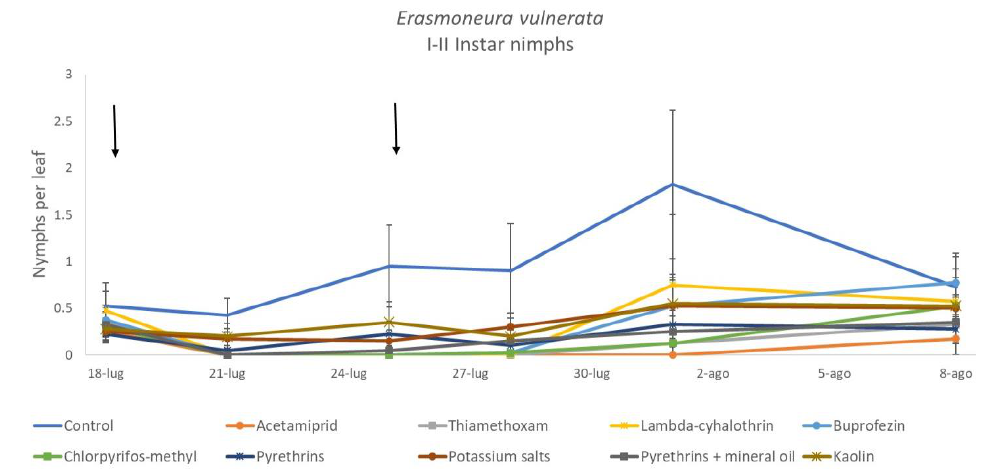
Figure 3. Dynamics of Erasmoneura vulnerata early (I-II instar) nymphs (mean ± std. err.) in the 2017 trial. Insecticides were applied one (first arrow) or two times (second arrow, see Materials and Methods section).